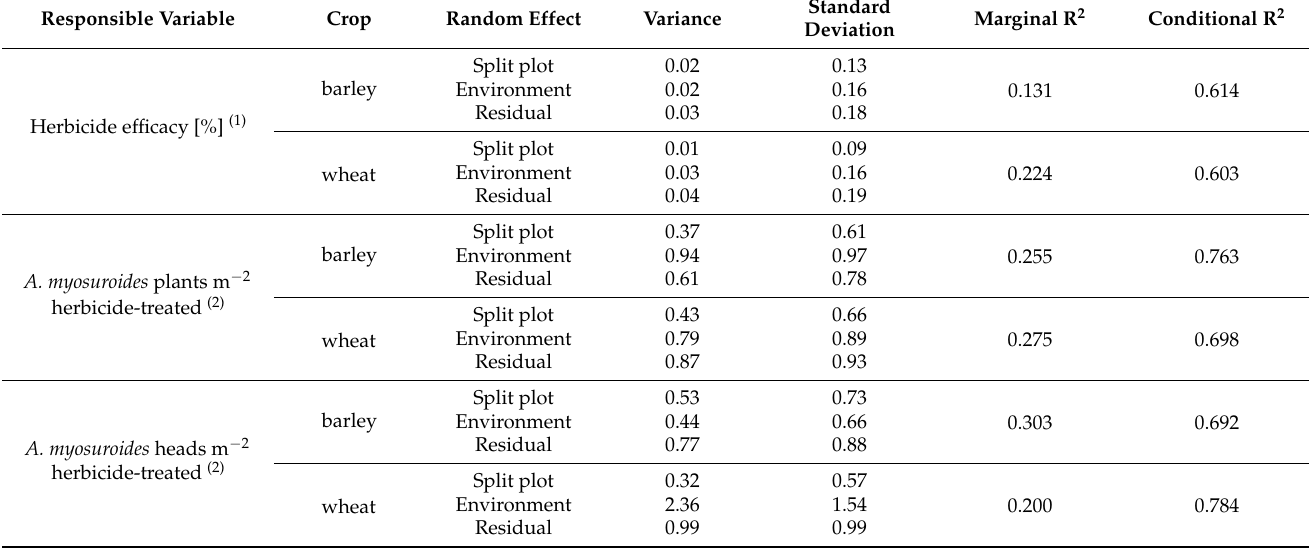
Table 6. Summary of crop-specific linear mixed effects models for the responsible variables: herbicide efficacy and A. myosuroides density (plants and heads) in herbicide-treated areas.